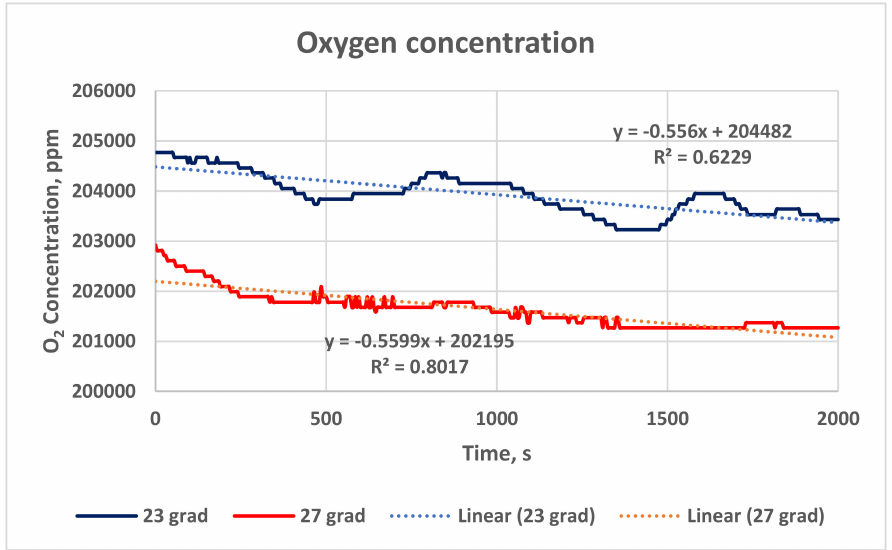
Figure 13. Oxygen concentration in the classroom during Stage 1 (27 ◦ C) and Stage 2 (23 ◦